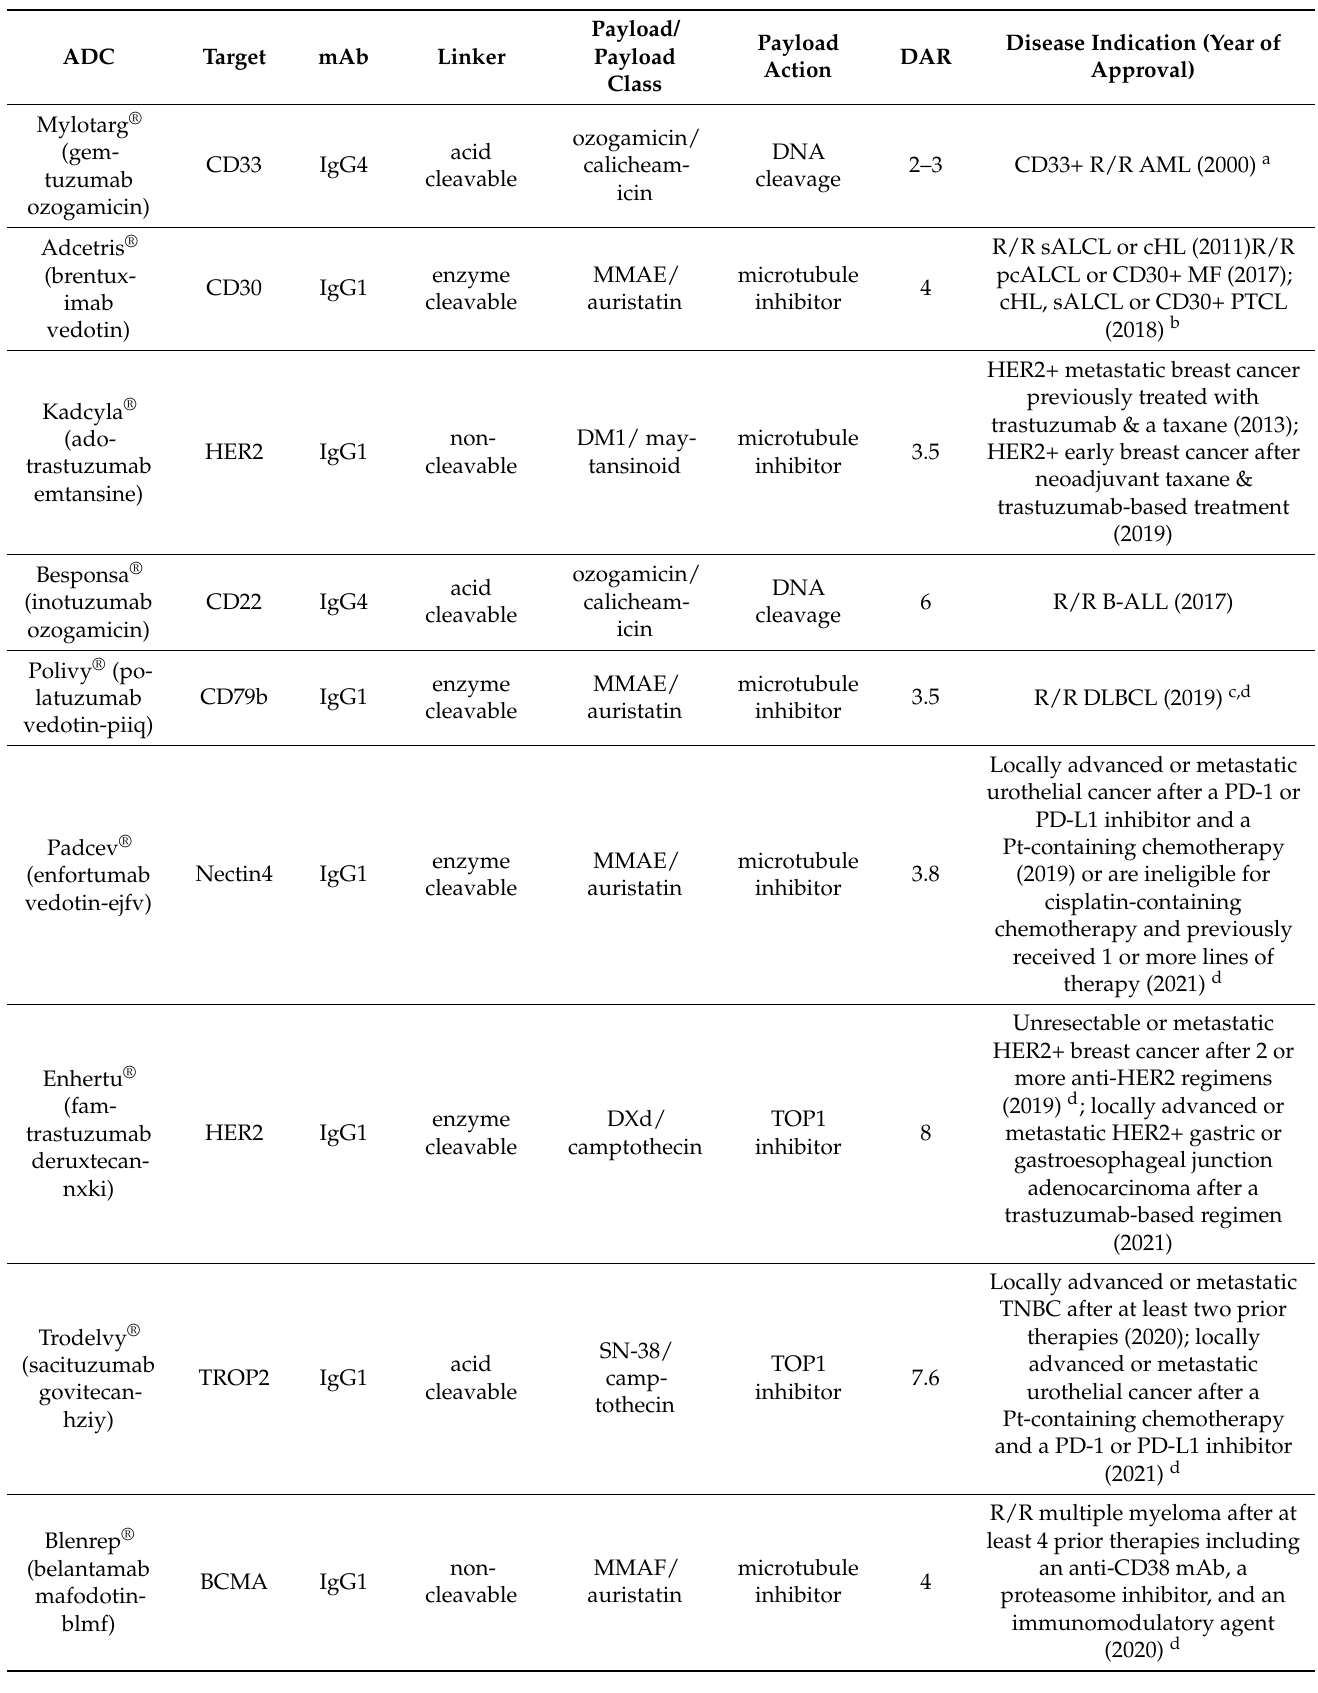
Table 1. FDA approved ADCs currently on the